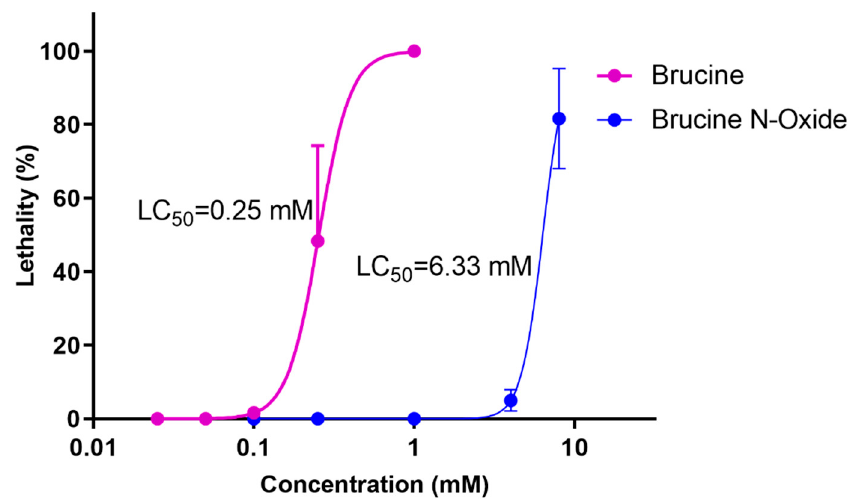
Figure 1. Dose-response curves of BRU- and BNO-induced acute toxicity in zebrafish.